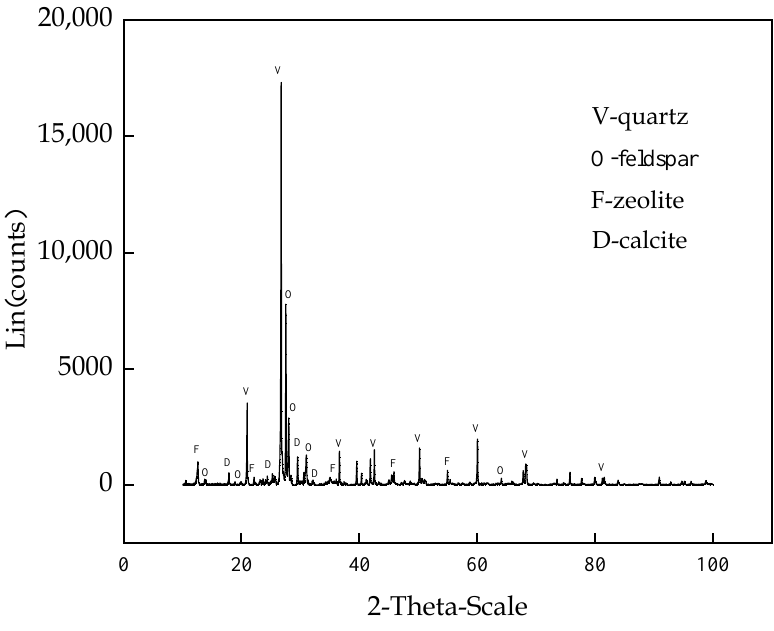
Figure 2. XRD phase analysis of classified fine tailings.